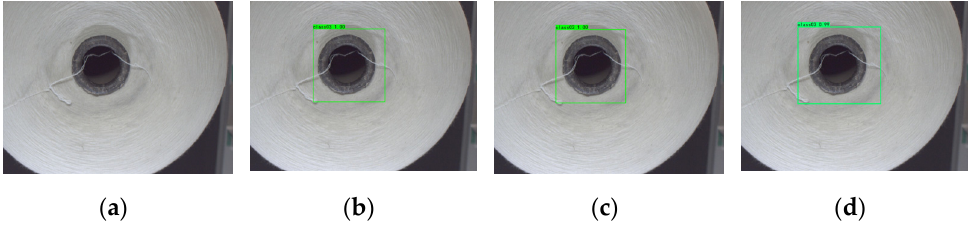
Figure 14. Identification of cone yarn with covered bobbin: ( a ) original image; ( b ) YOLOv3 + DarkNet-53 algorithm recognition results; ( c ) Faster R-CNN + VGG16 algorithm recognition results; ( d ) Faster R-CNN + ResNet50 algorithm recognition results.